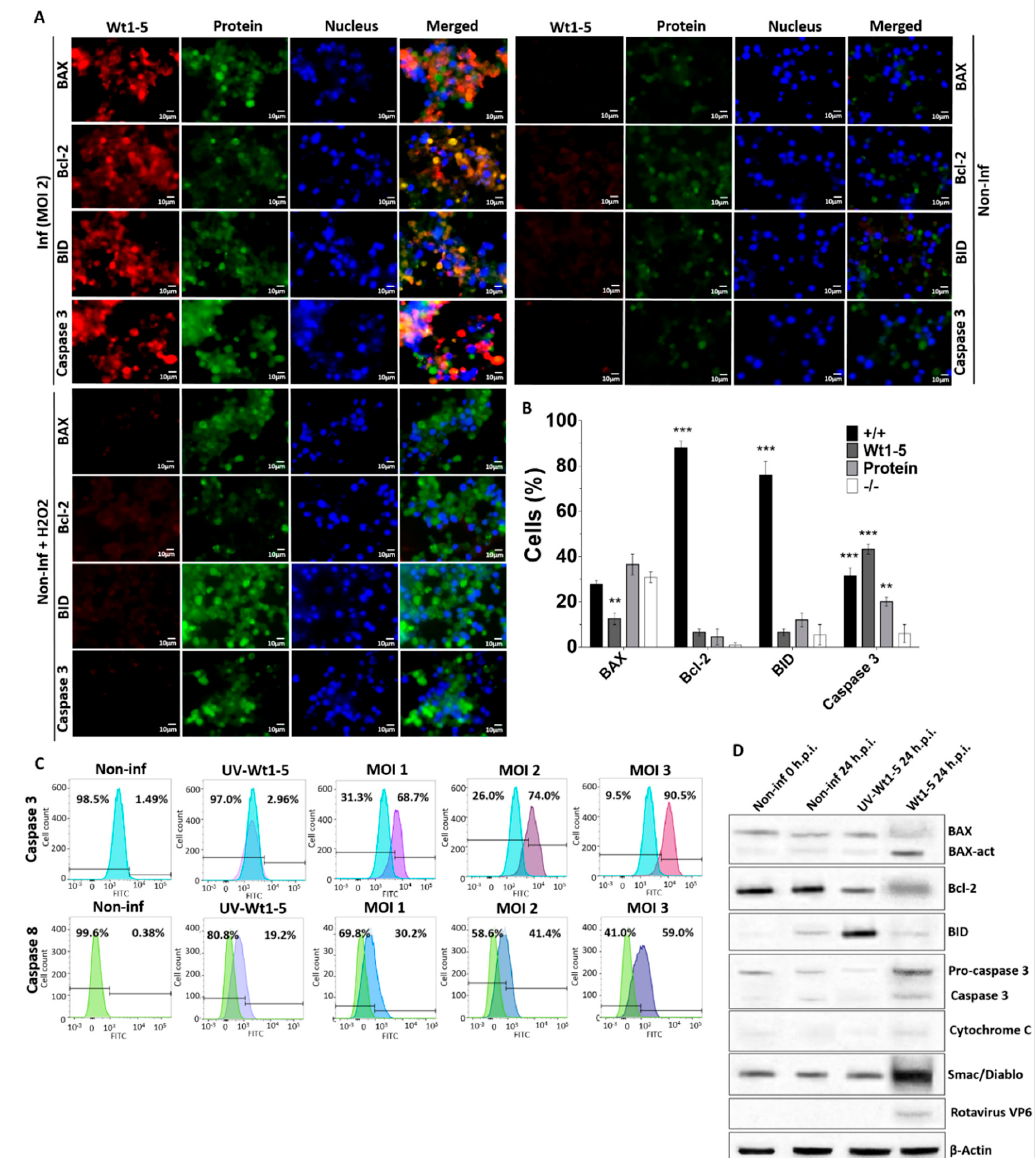
Figure 4. Cell death markers induced by Wt1-5 infection of Reh cells. Reh cells at a logarithmic growth phase were infected or not infected with trypsin-activated Wt1-5 (MOI 2) in RPMI culture medium without FBS. Non-infected cells treated with H 2 O 2 (1 mM) were used as a control. ( A ) Representative photographs of expression for cellular proteins BAX, Bcl-2, BID and Caspase 3 are shown at 24 h.p.i. Cellular proteins were stained with Alexa Fluor 488 (green) and viral structural antigens with Alexa Fluor 568 (red). Nuclei were stained with DAPI (blue). ( B ) Quantitative analysis of images shown in (a) is expressed in terms of percentages of cells being positive for cellular proteins or Wt1-5 structural proteins. (+/+): cells positive to both viral proteins and cellular proteins; ( − / − ): cells negative for both viral proteins and cellular proteins. ( C ) Flow cytometry analysis at 24 h.p.i. of Wt1-5-infected cells at MOI 1–3 for activation of caspases 3 and 8. Non-infected cells and UV-inactivated Wt1-5-infected cells at MOI 2 were used as a control. Histograms for non-infected and infected cells were overlapped. Percentages of positive cells are on the right and negative ones on the left. Results are from two different assays. ( D ) Lysates from Wt1-5-infected cells at MOI 2 were analyzed by SDS-PAGE/Western blotting at 24 h.p.i. using antibodies to BAX, activated-BAX, Bcl-2, BID, pro-caspase 3, caspase 3, cytochrome C, Smac/Diablo, rotavirus VP6 and β -actin. Lysates from non-infected cells at 0 and 24 h.p.i. were used as a control. Data are shown as mean ± SD of three independent experiments performed in duplicate. Statistical significance is indicated by p -values (*** p ≤ 0.01, ** p ≤ 0.05, and * p ≤